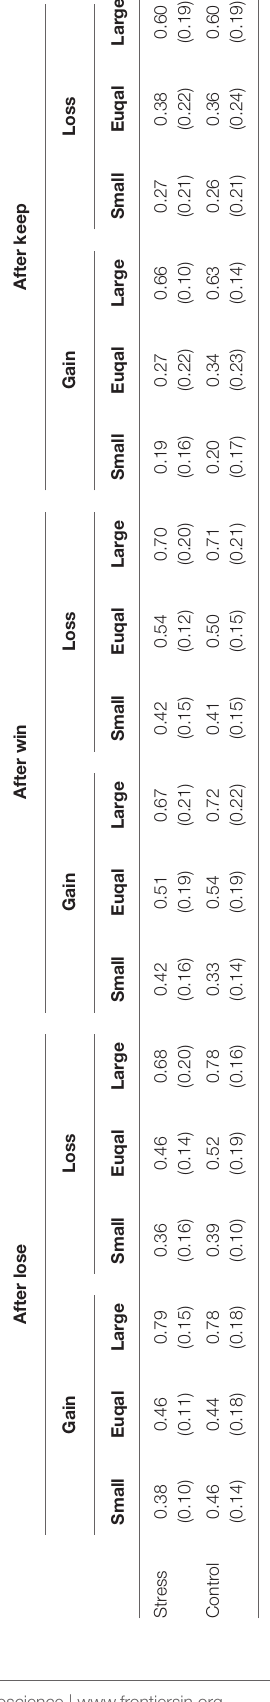
( Figure 8D ) fit the data reasonably well, as indicated by multiple indicators of fit: ratio chi-square/df = 0.43, RMSEA = 0.00, and GFI = 0.99. The AIC value comparing improvement of fit strongly decreased from 34.48 for Model 3 to 16.44 for Model